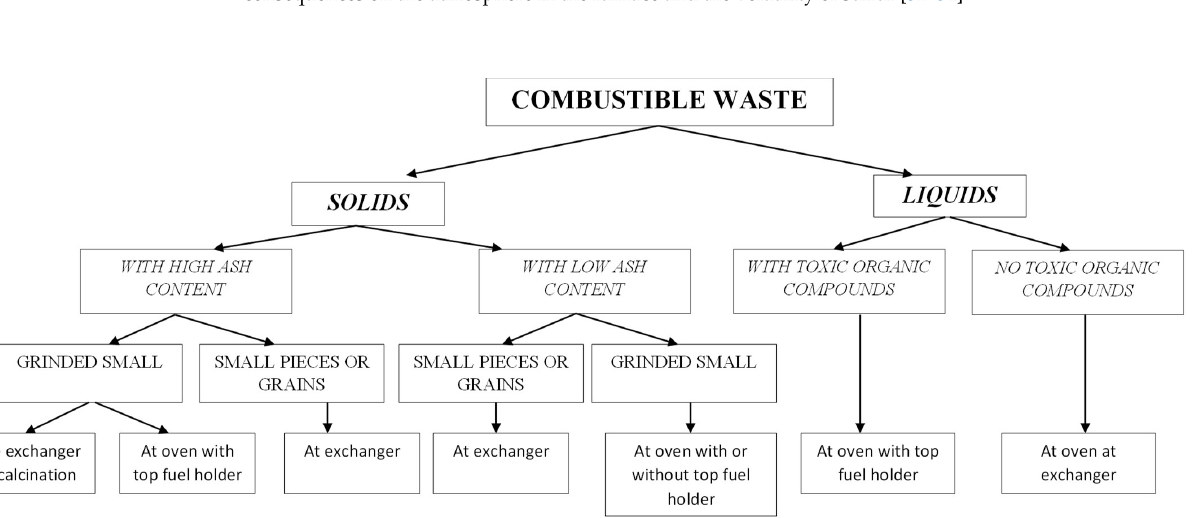
Figure 7. The diagram for establishing fuel waste supply points.